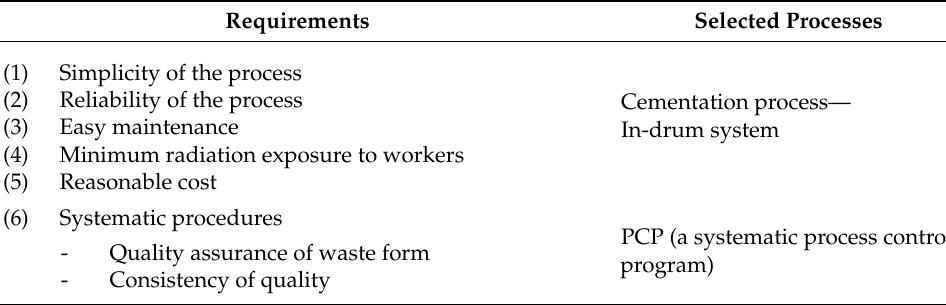
Table 2. Requirements to consider when selecting a solidification